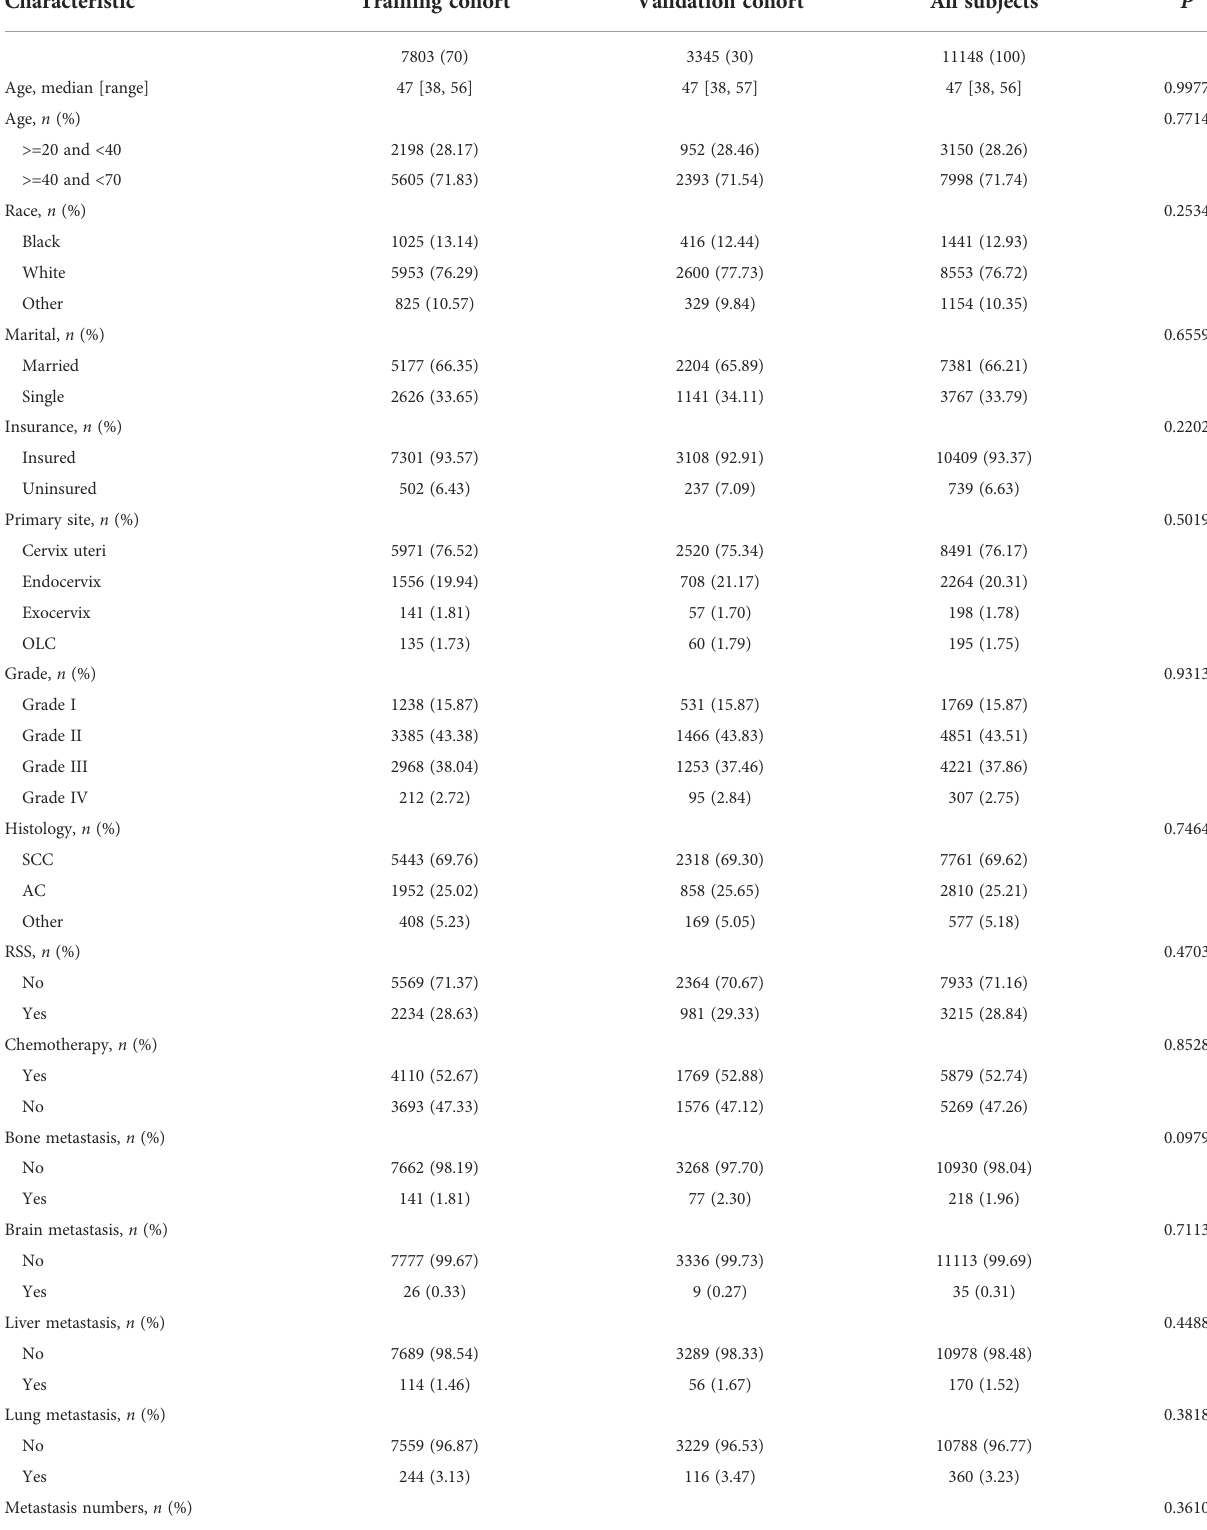
TABLE 1 Characteristics of patients with cervical cancer in the training cohort and validation cohort.